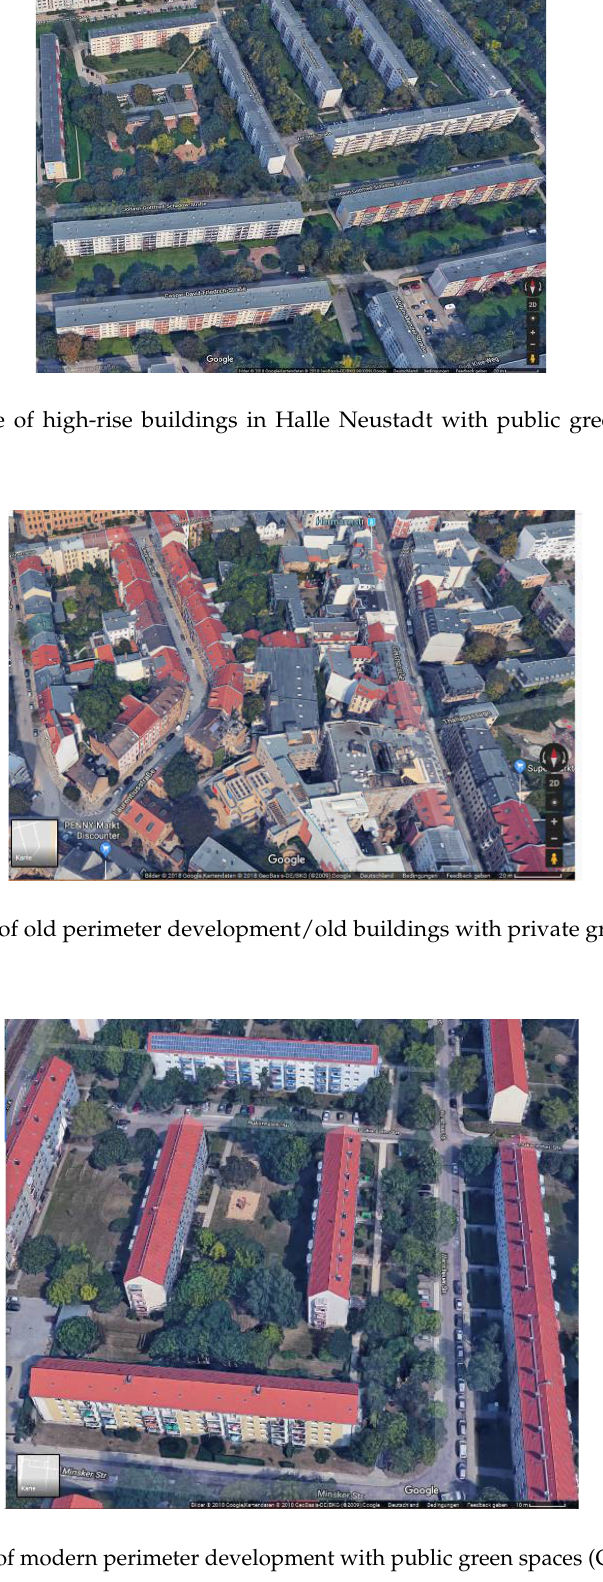
Figure A3. Example of modern perimeter development with public green spaces (Google Maps 2018).